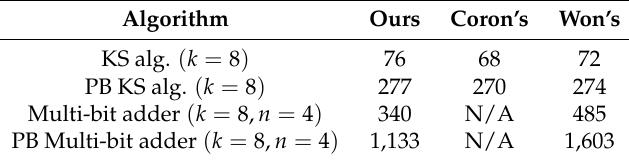
Table 7. Comparison of the total number of operations